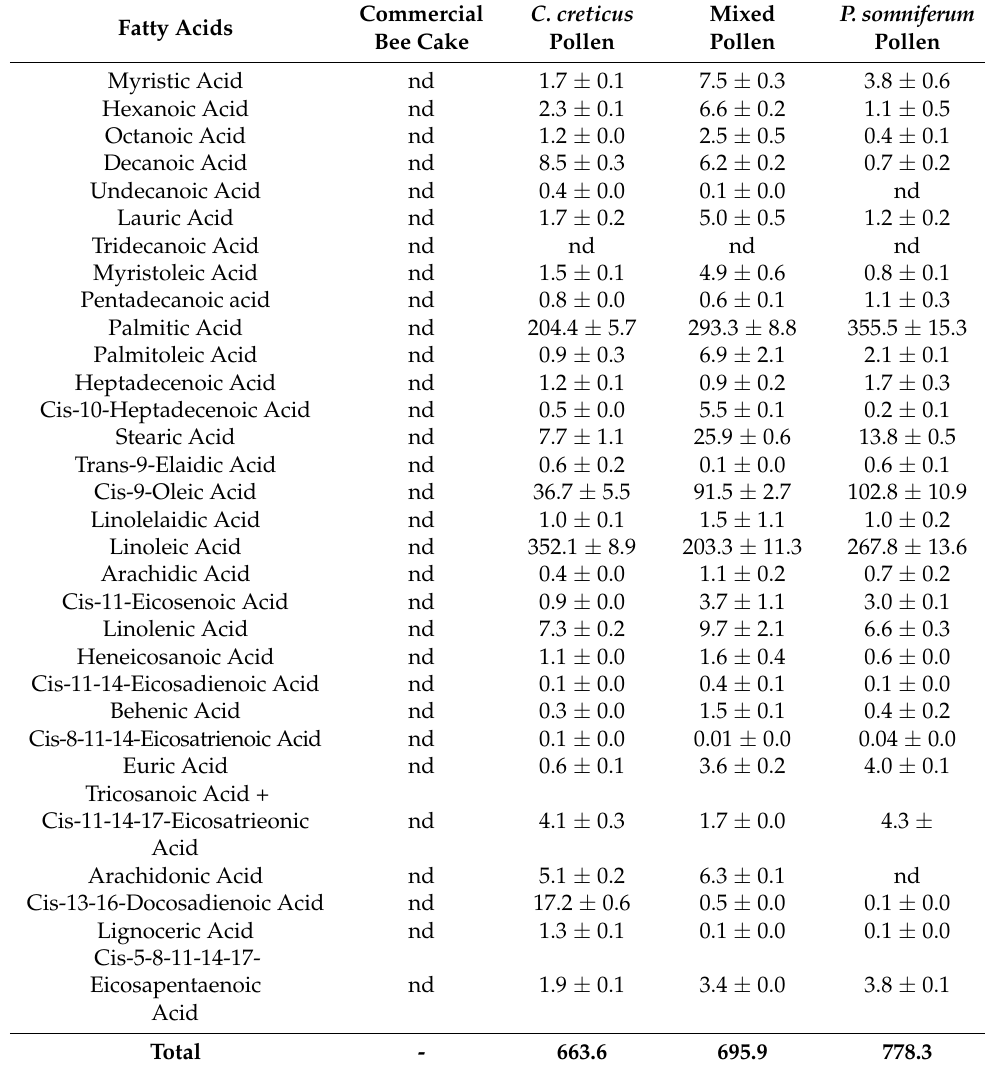
Table 1. Fatty acid composition of feeds in experimental groups (mg/100 g pollen or bee